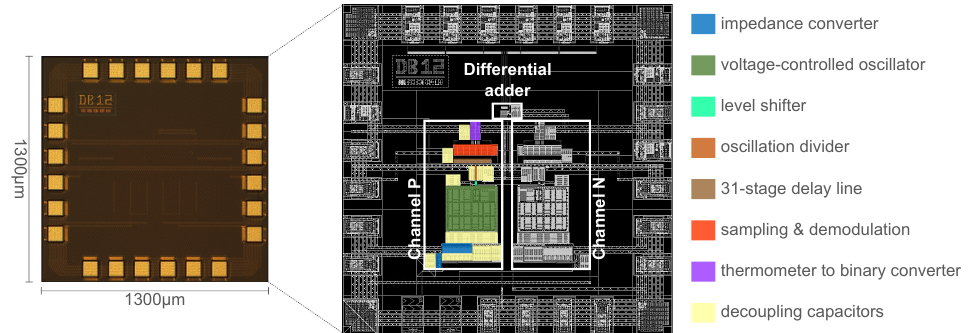
Figure 11. Die micrograph and area